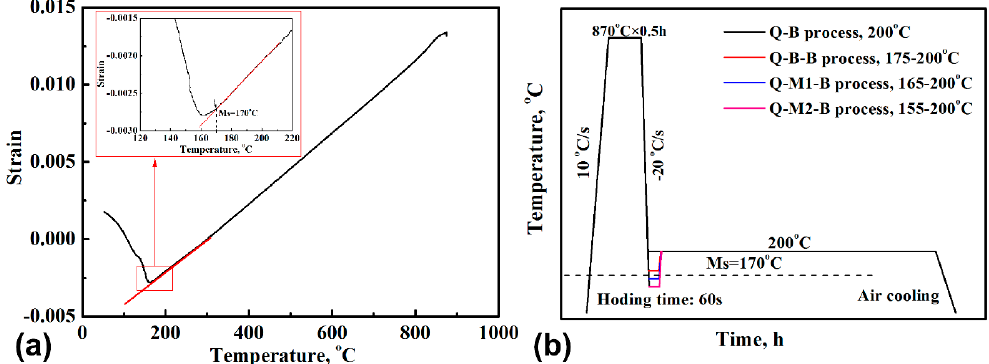
Figure 1. The strain-temperature curve for determining the ( a ) Ms temperature and ( b ) detailed heat treatment process.